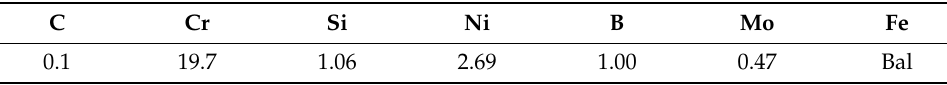
Table 2. Chemical composition of laser cladding powder